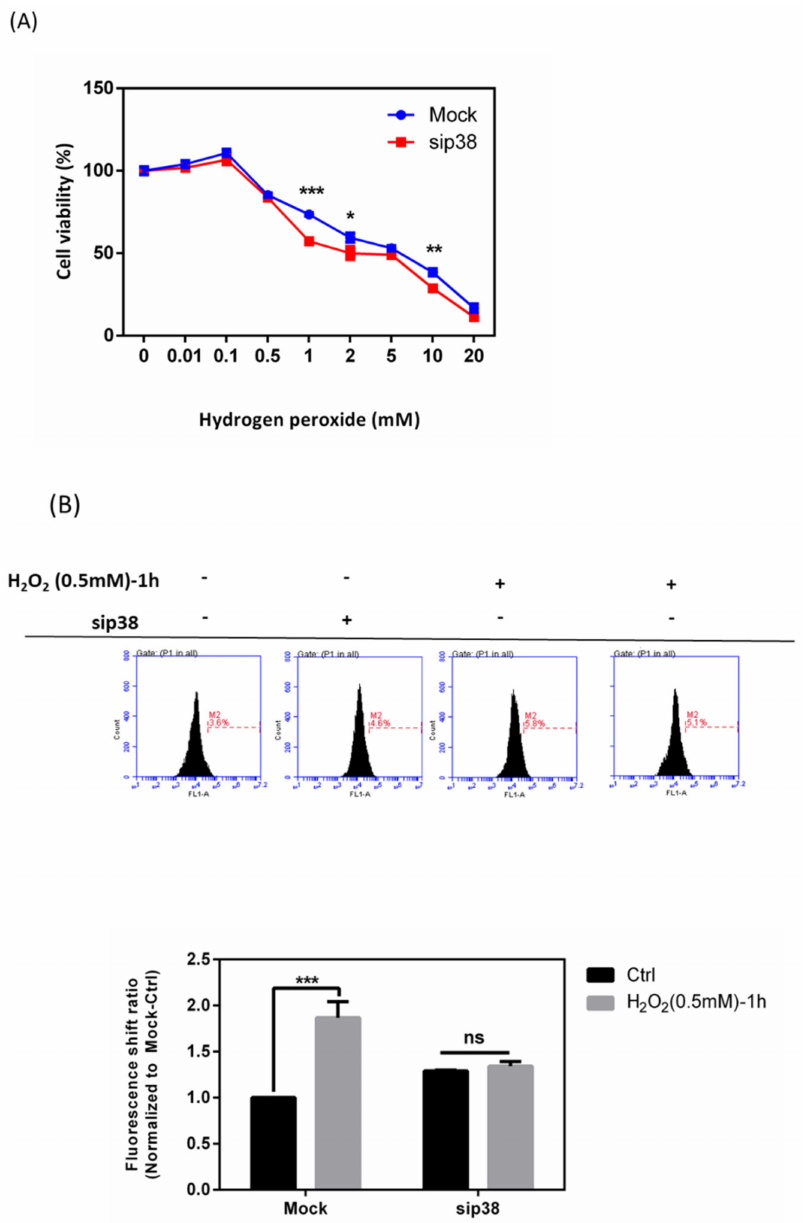
Figure 9. Effects on sip38 MAPK knockdown HTMCs through H 2 O 2 exposure. ( A ) sip38 MAPK knockdown HTMCs decreased cell viability with H 2 O 2 at different concentrations for 1 h when compared to the si-control (mock) group. Data reflect that ssip38 MAPK knockdown HTMCs were more susceptible and sensitive to oxidative stress. Values in the plots are normalized against the control group (Mock-Ctrl); Statistic chart were represented as means ± SEM. *, p < 0.05; **, p < 0.01; ***, p < 0.001; ( n = 3, independent experiments). ( B ) Levels of ROS intensity in sip38 MAPK knock- down HTMCs with or without H 2 O 2 treatment (0.5 mM) for 1 h. Data show that insip38 MAPK knockdown HTMCs had increased ROS levels; H 2 O 2 (0.5 mM) treatment for 1 h led to no significance increase. Values in the plots are normalized against the control group (Mock-Ctrl); Statistic chart were represented as means ± SEM. ***, p < 0.001; ns, non-significant; ( n = 3, independent